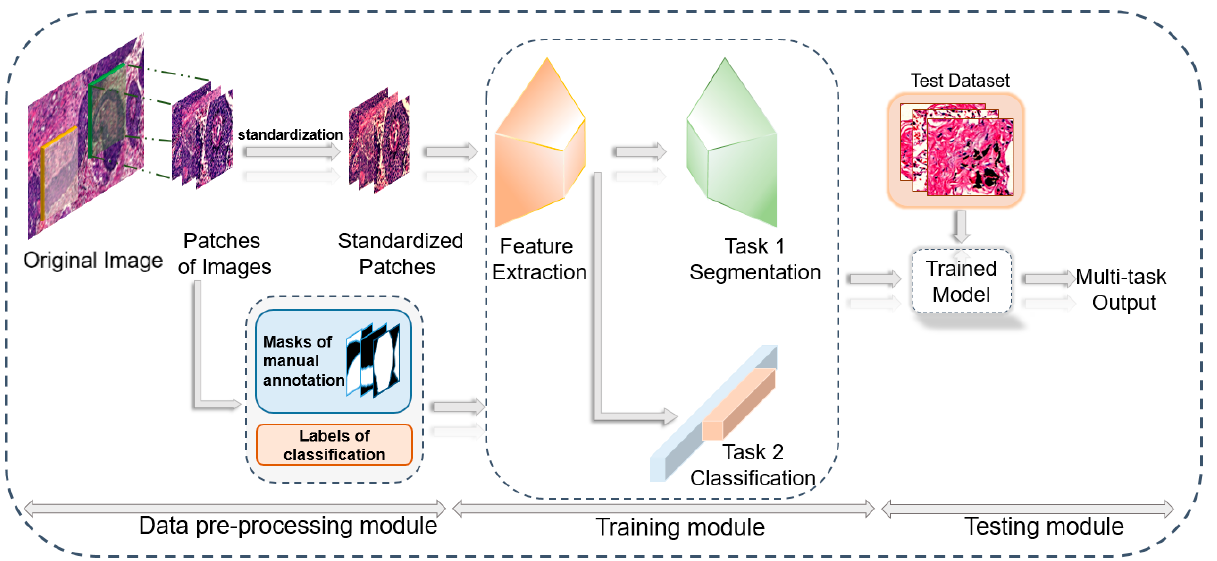
Figure 1. Structure of our research. A data pre-processing module was developed to annotate, crop and standardize original images into image patches and corresponding ground truth. With the training module and testing module, the multi-task model was trained and tested.